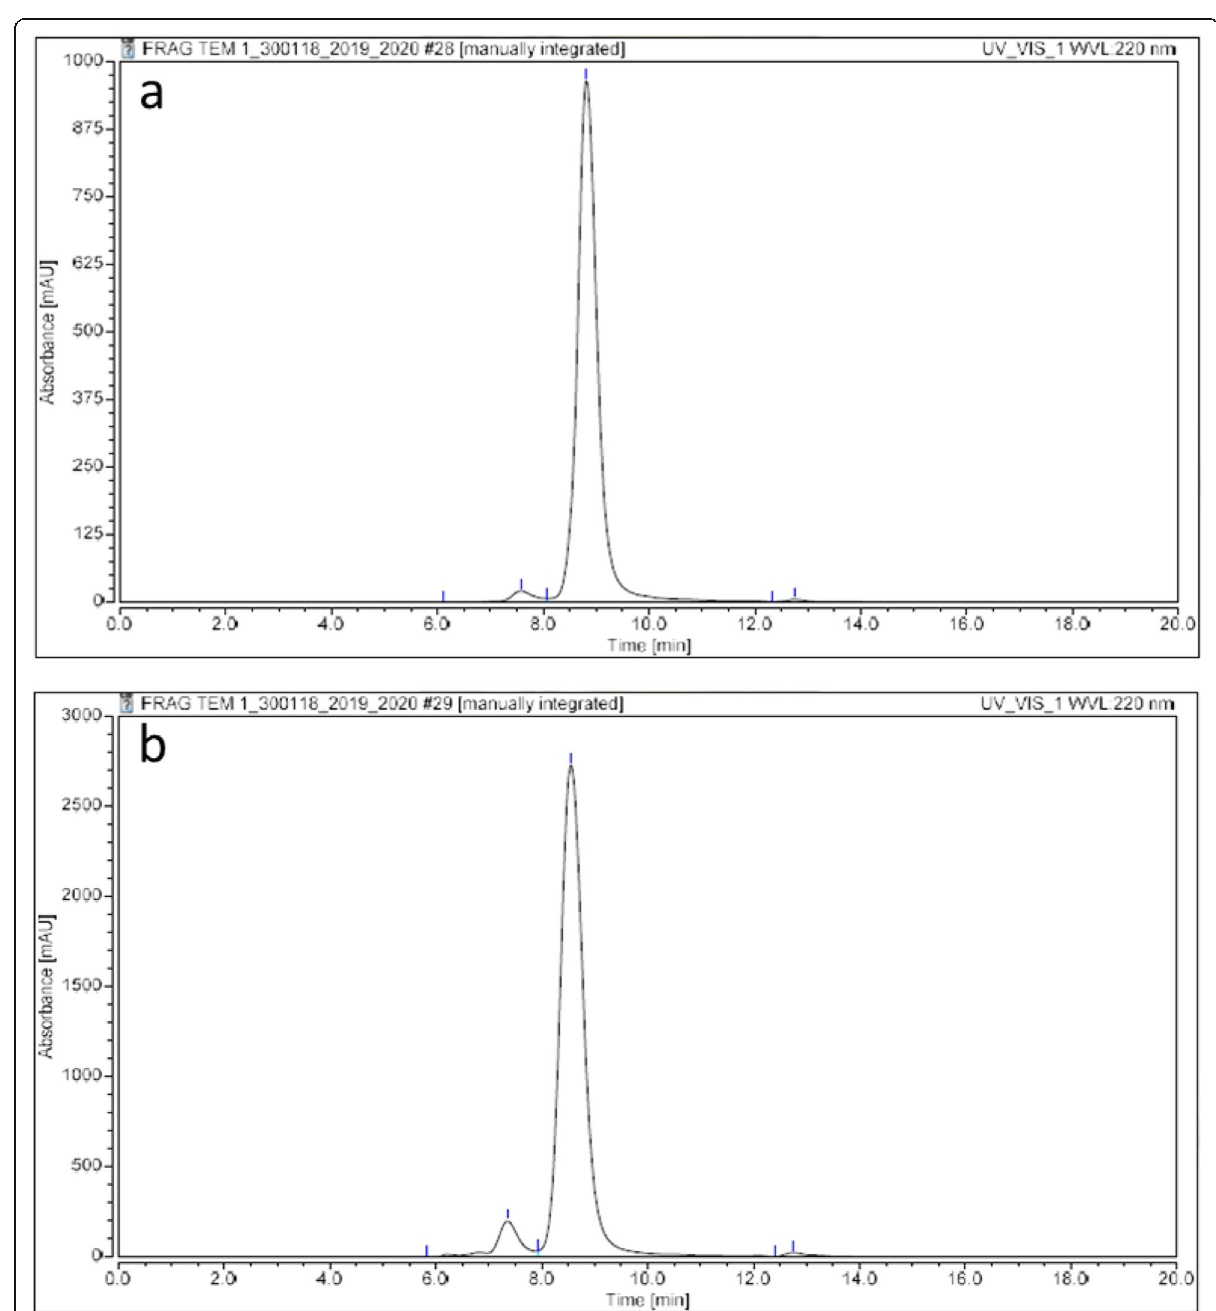
Fig. 2 Results of HPLC analysis. a Native 1C1m-Fc. b 1C1m-Fc conjugated with 20 eq. of